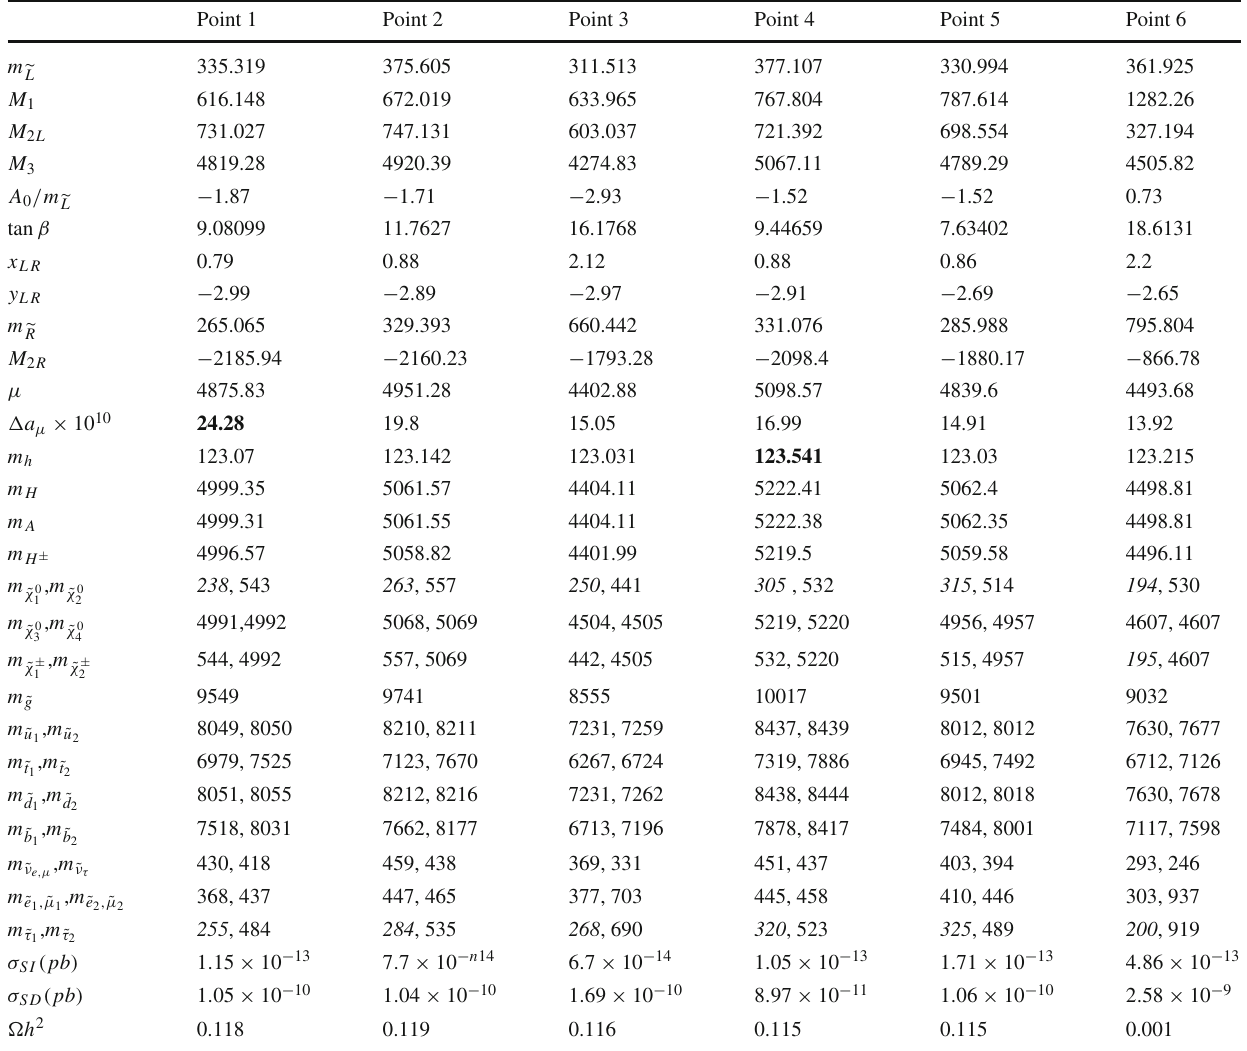
Table 2 Benchmark points satisfy the mass bounds, the constraints from rare B-meson decays, Planck measurements within 5 σ and muon g − 2 solution within 2 σ at most. All masses are in GeV. Point 1 shows a solution that has muon g − 2 value closest to its world average. Points 2 and 3 display solutions with the possible largest tan β consistent with